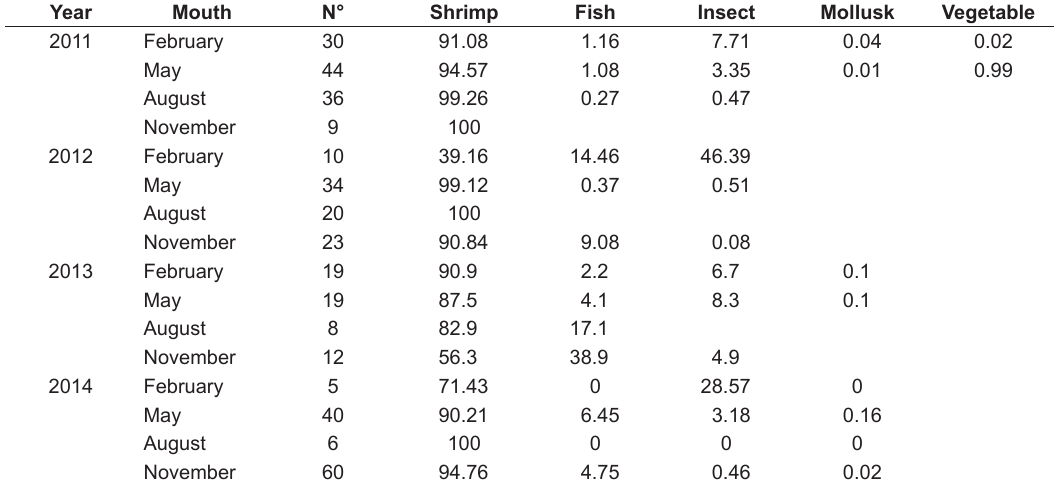
Table 1. Feeding Index (IAi), month and year of sample, of Plagioscion squamosissimus , collected quarterly, between February 2011 and November 2014, at the Santa Cruz Reservoir, Rio Grande do Norte. N° - number of stomachs analyzed.